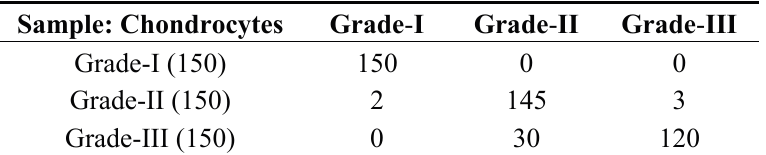
Table 1. Classification matrix provides the information about classification ability and prediction efficiency of PCA